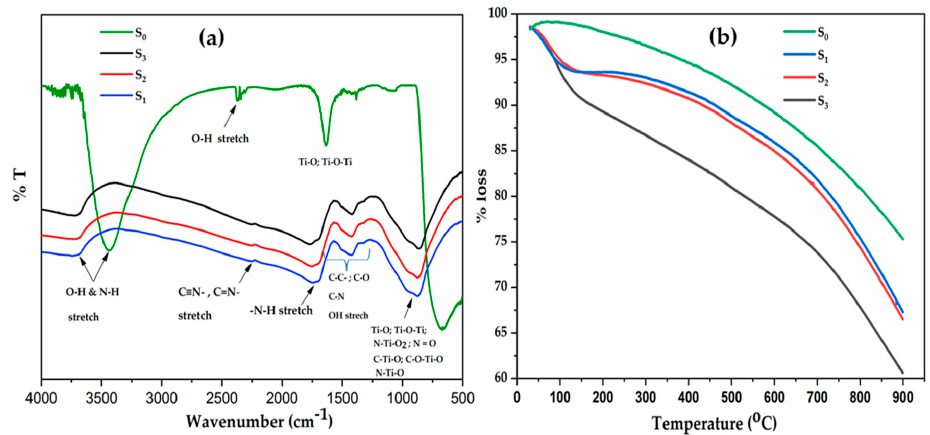
Figure 2. ( a ) FTIR spectra and ( b ) thermal gravimetric analysis (TGA) of C–N–TiO 2 nano composites